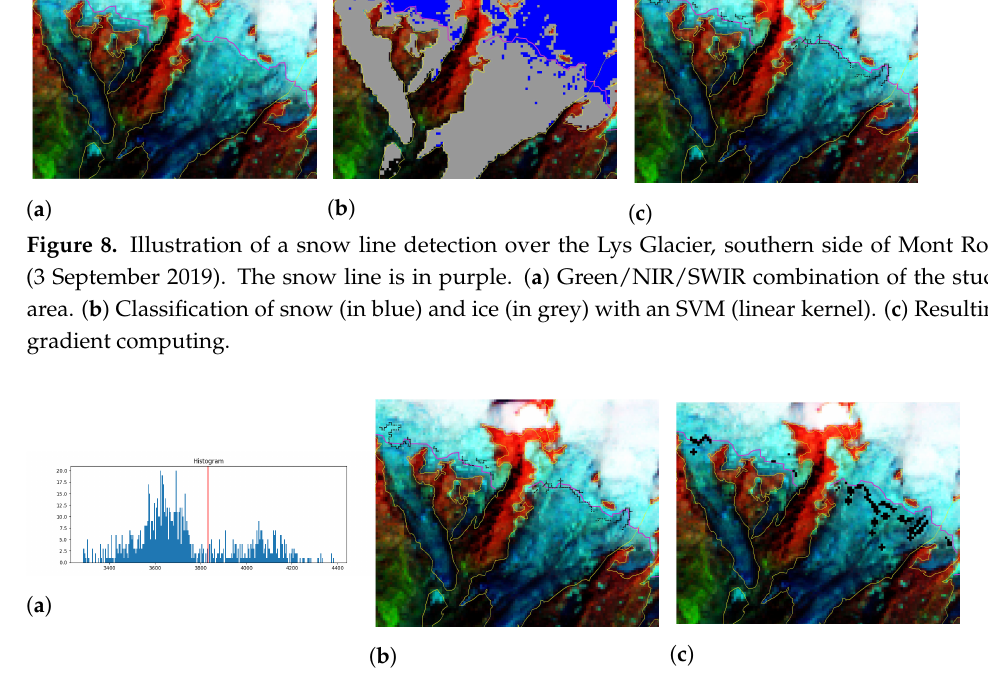
Figure 9. Illustration of a corrected snow line detection over the Lys Glacier, where the corrected snow line does not contains the gradient of the packs of ice around the snow part of the glacier that were removed with respect to their elevation. ( a ) Histogram of the elevation values of the classification map’s gradient of the Lys Glacier; the red line is the selected threshold by the Otsu method [49]. ( b ) Resulting gradient of the classification map of the Lys Glacier of Lys overlaid on a Green/NIR/SWIR spectral bands combination. ( c ) Corrected gradient thresholded by its elevation value with regard to the detected Otsu threshold. Purple line in ( b , c ) is the ground truth snow